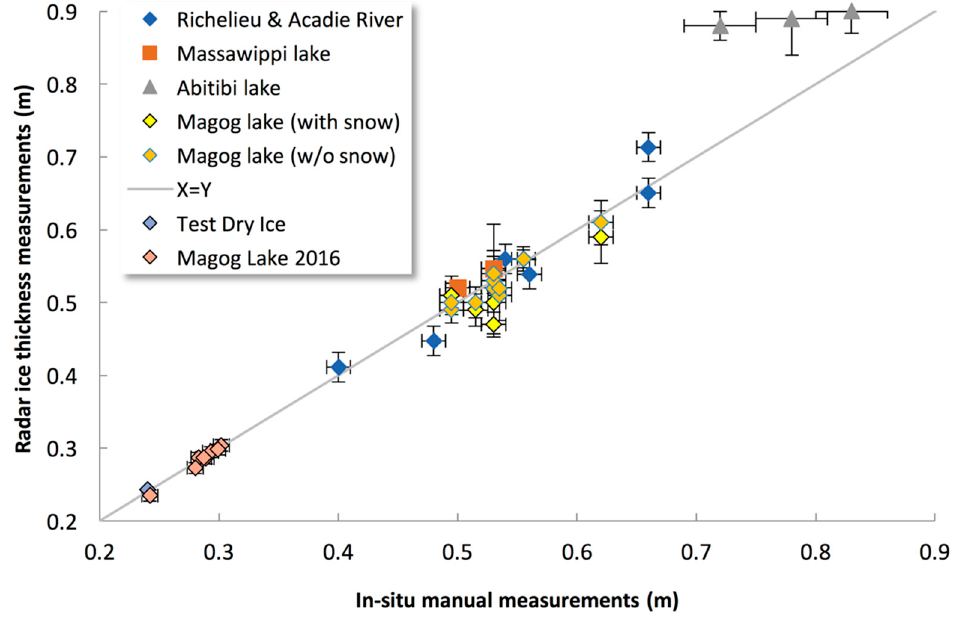
Figure 7. Radar ice thickness measurements compared to in situ manual measurements under frozen conditions. All radar data are from operational automatic retrievals. The horizontal and vertical lines at each point give the in situ and radar precision, respectively.